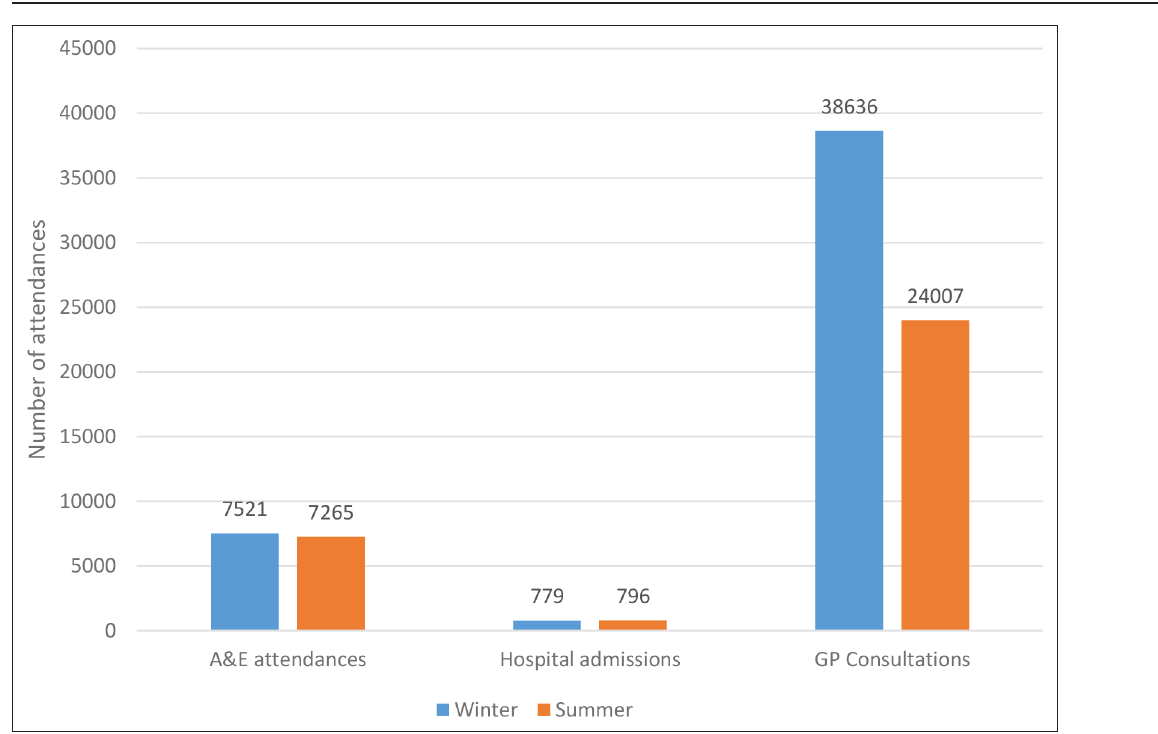
Figure 1 Comparison of seasonal variation in primary and secondary